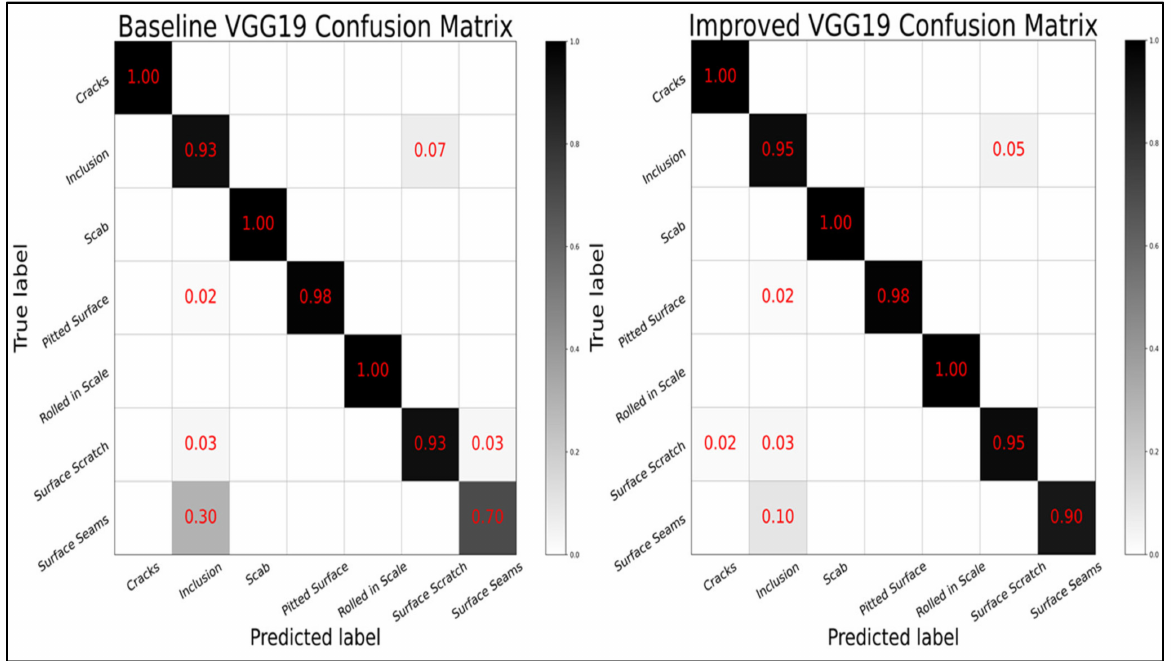
Figure 17. Confusion matrix of the test dataset.